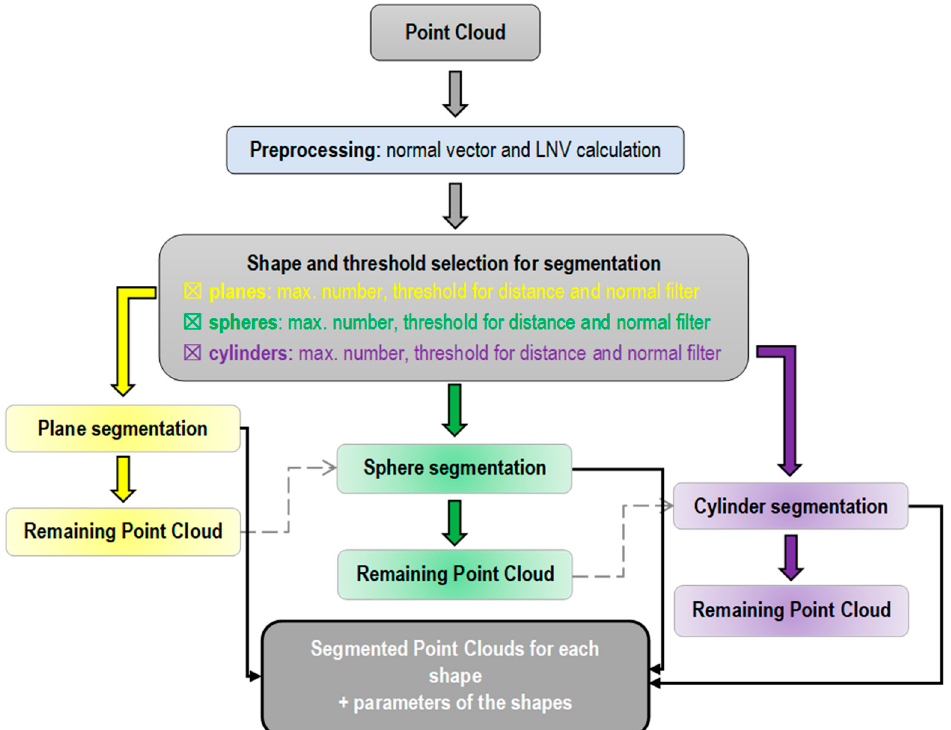
Figure 1. Flowchart of the algorithm proposed.